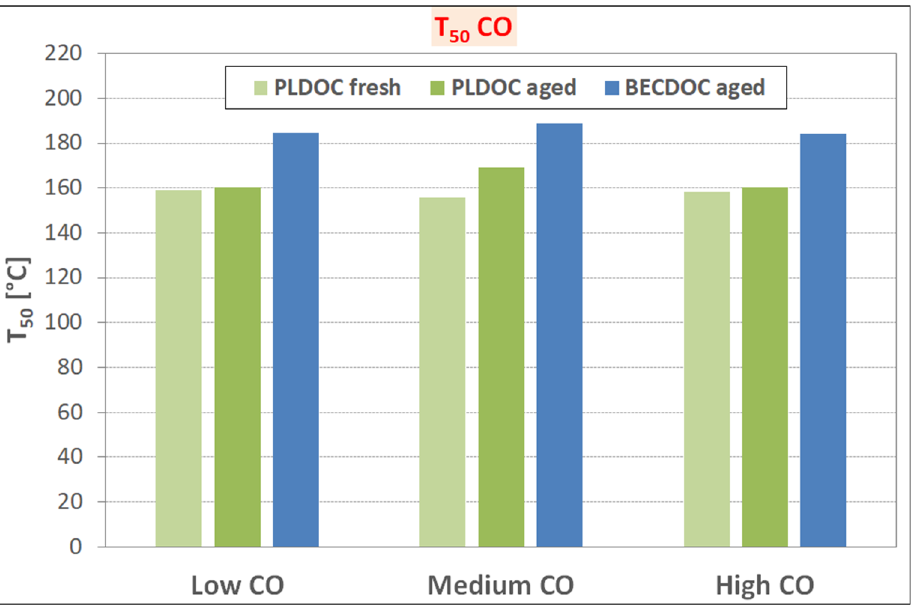
Figure 11. DOC light-off test: T 50 (CO)—average values.